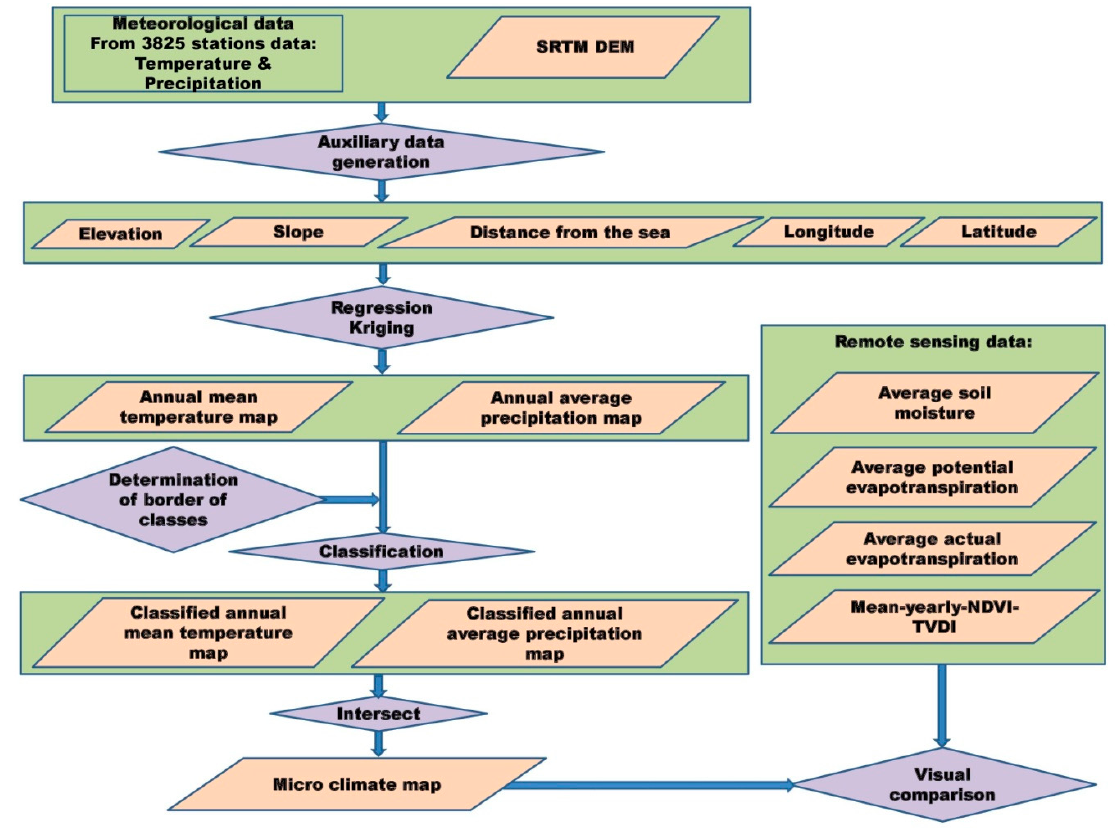
Figure 1. The methodology of the study.